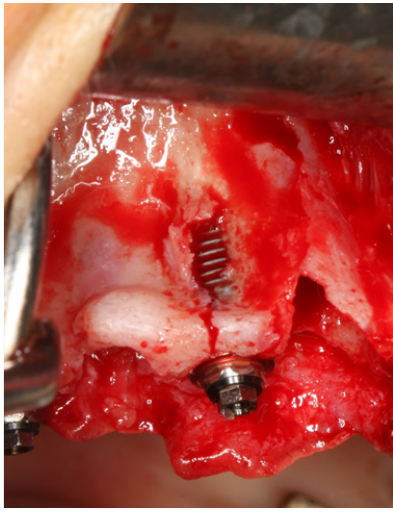
Figure 2. Intraoral photograph illustrating a fenestration, defined as a buccal or lingual window defect leaving marginal bone in situ.